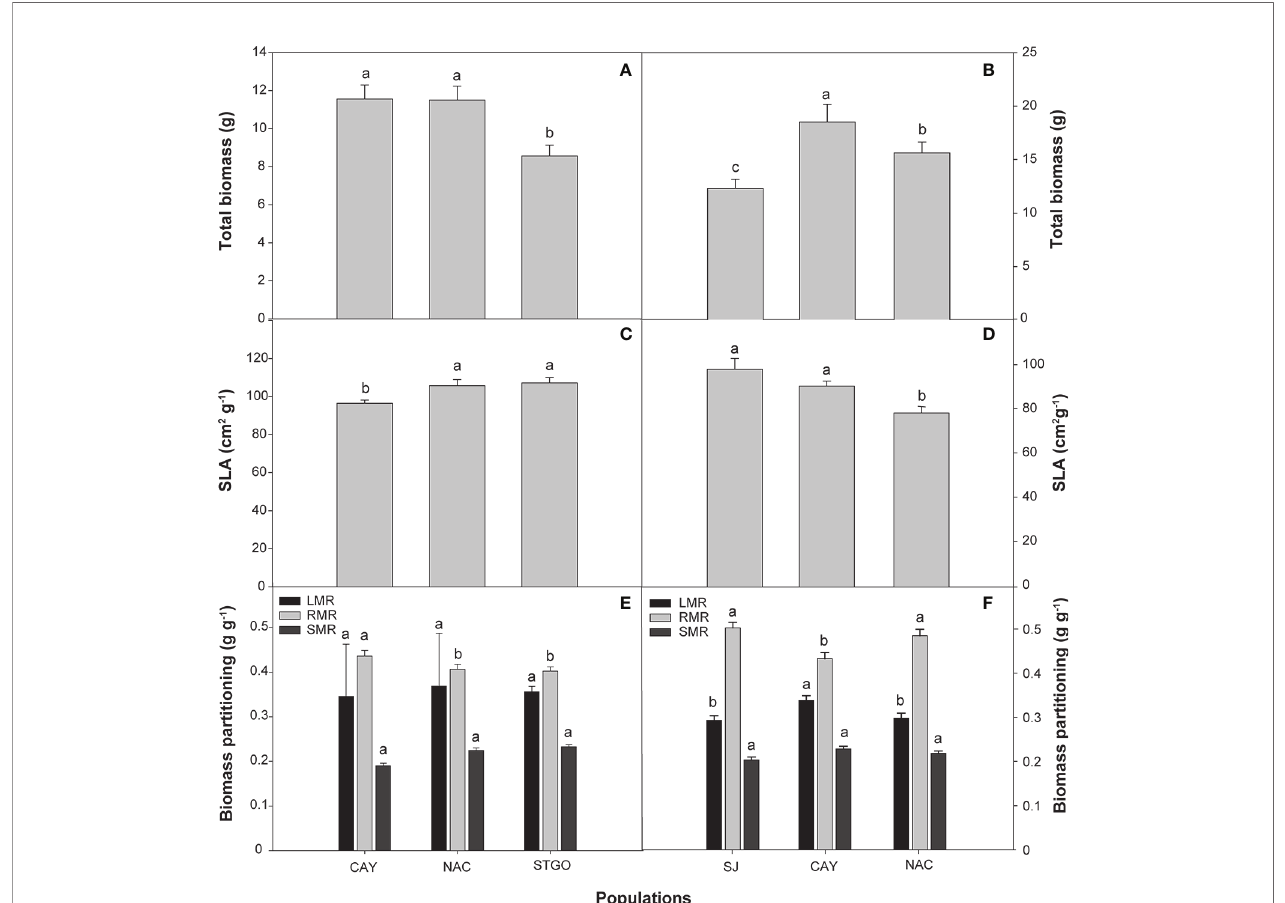
FIGURE 6 | Effect of population on total biomass (g), speci fi c leaf area (SLA, cm 2 g -1 ), and biomass partitioning (g g -1 ) of Cryptocarya alba (A, C, E) and Persea lingue (B, D, F) plants. Bars indicate means + SE. Different letters indicate signi fi cant differences according to Tukey at p<0.05. CAY, Cayumanque; NAC, Nacimiento; STGO, Santiago; SJ, Santa Juana; LMR, leaf mass ratio; RMR, root mass ratio; SMR, stem mass